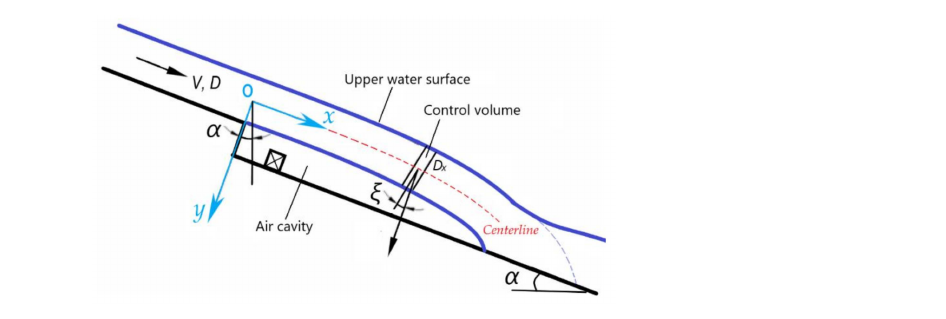
Figure 4. Definition sketch of aerator flow, derivation of jet trajectory centerline expression.